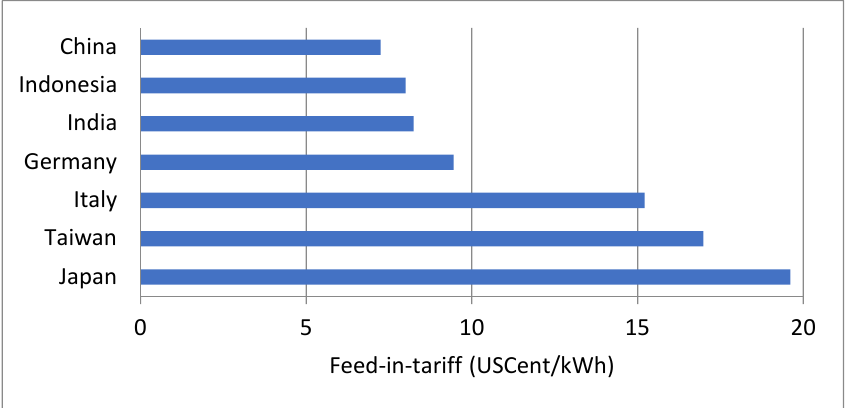
Figure 16. Comparison of feed-in tariffs for electricity from wind energy in selected countries in 2017 [29,32,33].